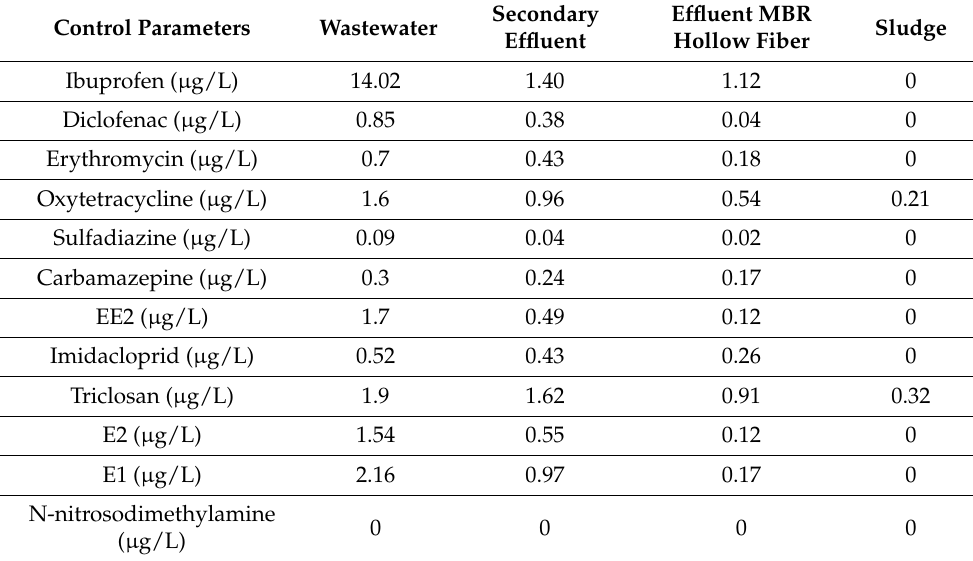
Table 5. Average concentrations of the emerging pollutants selected as a model for monitoring at WWTP A. Control